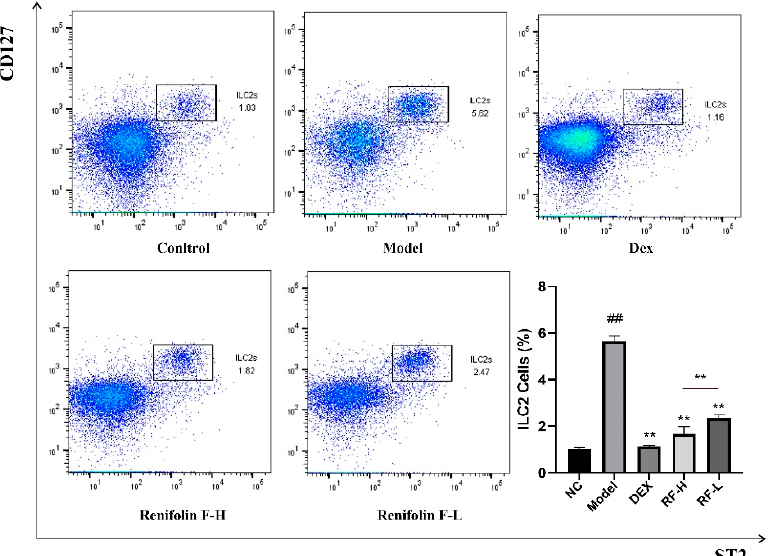
Figure 7. The effects of Renifolin F on the frequency of ILC2s cells in the lung. Normal control, saline-induced mice only. Model, OVA-induced mice. Dex, OVA-induced mice treated with Dex (1.0 mg/kg). RF-H, OVA-induced mice treated with Renifolin F (3.0 mg/kg). RF-L, OVA-induced mice treated with Renifolin F (1.5 mg/kg). Statistics represented as the mean ± SEM ( n = 6). ## p < 0.01 vs. Normal control and ** p < 0.01 vs. Model.